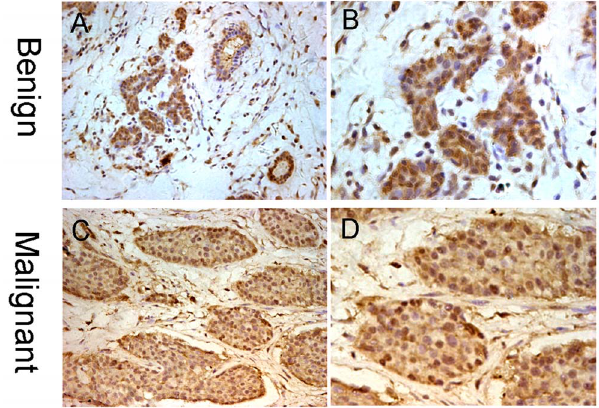
Figure 1. An immunohistochemical analysis of Foxo3a protein in human breast tissues. (Original magnification 6 200(A,C), 6 400(B,D)). Expression of Foxo3a in Benign breast tissue(A,B). Brown nuclear and cytoplasmic Foxo3a staining were showed in epithelial cells lining the ducts. Expression of Foxo3a in malignant mammary gland tumors(C,D). All of the staining accumulated in the nucleus and cytoplasm. doi:10.1371/journal.pone.0070746.g001 PLOS ONE |